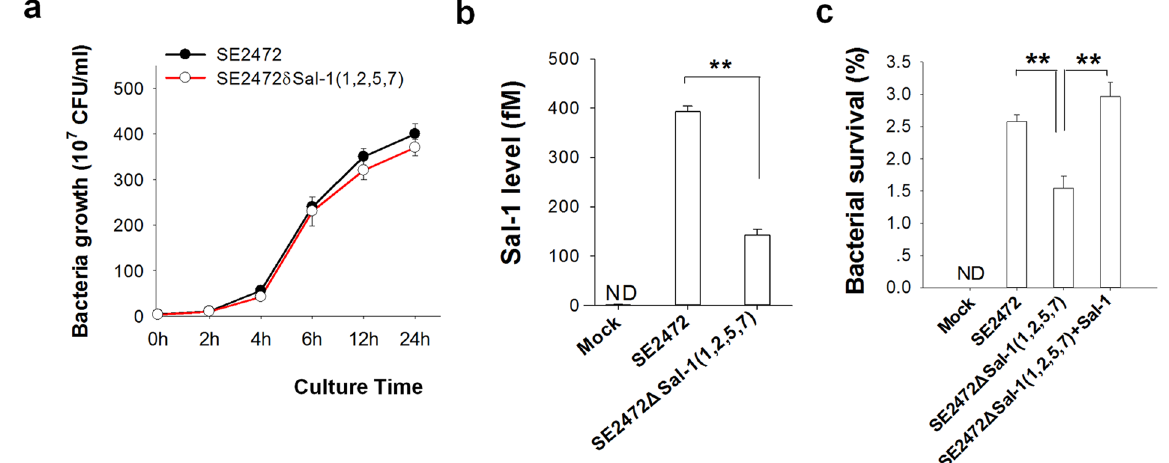
Figure 6. Deletion of Sal-1 sequence in bacterial genome decreases the bacterial intracellular survival rate following Salmonella infection. ( a ) Bacterial growth rate. ( b ) Level of Sal-1 in HT-29 cells infected with WT SE2472 or mutant SE2472 ∆ Sal-1(1,2,5,7). ( c ) The level of bacterial intracellular survival rate in HT-29 cells infected with SE2472 or mutant SE2472 ∆ Sal-1(1,2,5,7). Note that delivery of Sal-1 into SE2472 ∆ Sal-1(1,2,5,7) -infected cells via Sal-1-expressing lentivirus largely repairs the defect of SE2472 ∆ Sal-1(1,2,5,7) in promoting bacterial survival. ND, not detected. ** P < 0.01.